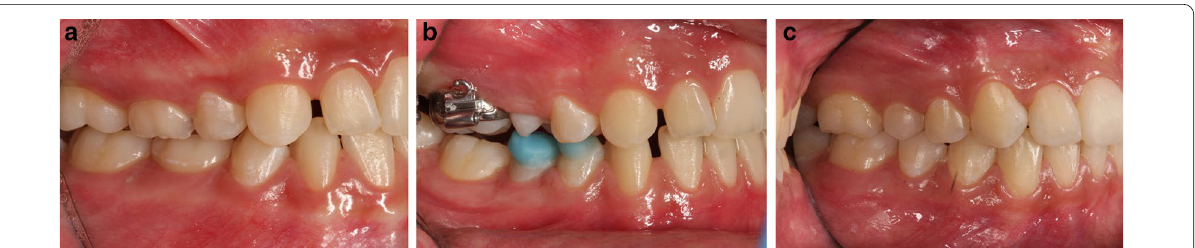
Fig. 3 a – c Profile photographs of one patient of the study group at T0, T1, and T2